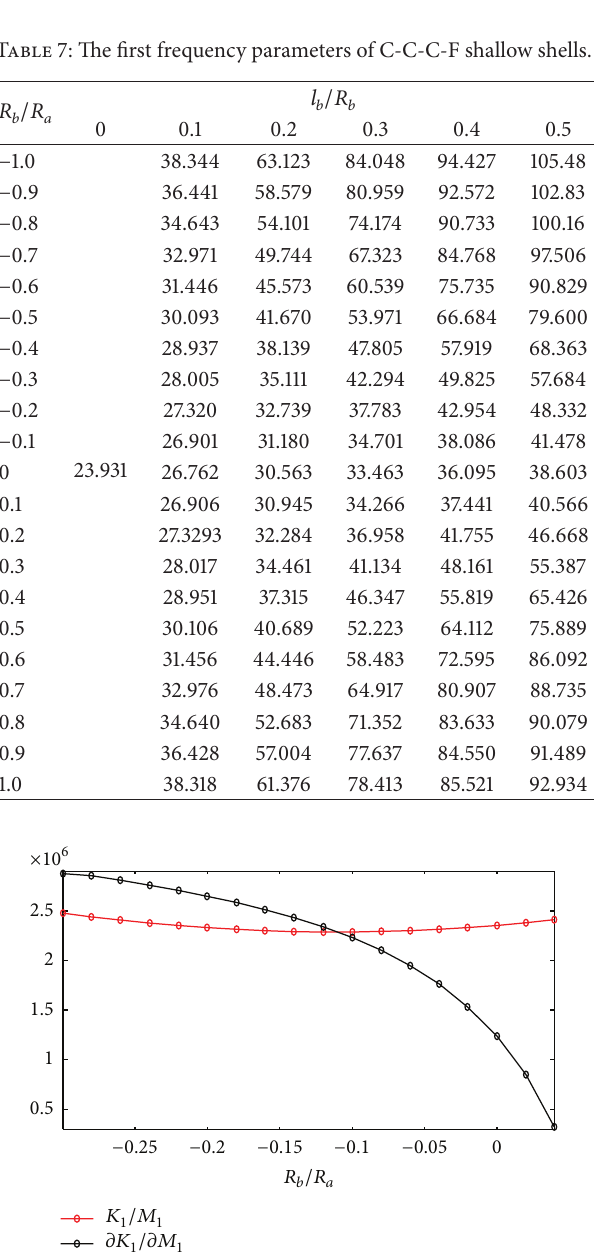
Figure 7: The value of 𝐾 1 /𝑀 1 and 𝜕𝐾 1 /𝜕𝑀 1 as functions of cur- vature ratio for a C-C-C-C